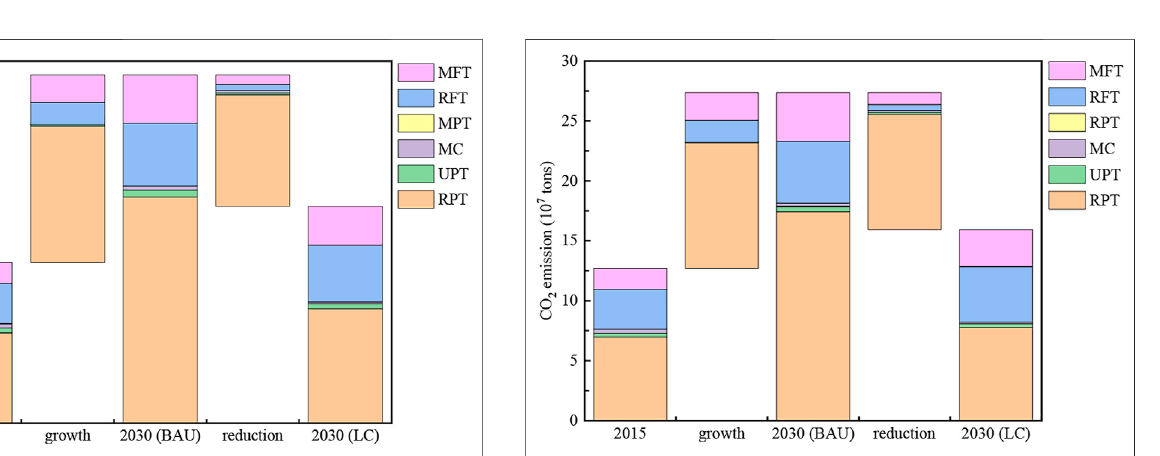
FIGURE 8 | Energy consumption reduction of different modes of transportation in Guangdong Province. Note marine freight transport (abbreviated as MFT); road freight transport (abbreviated as RFT); marine passenger transport (abbreviated as MPT); motorcycle (abbreviated as MC); urban public transport (abbreviated as UPT); road passenger transport (abbreviated as RPT).